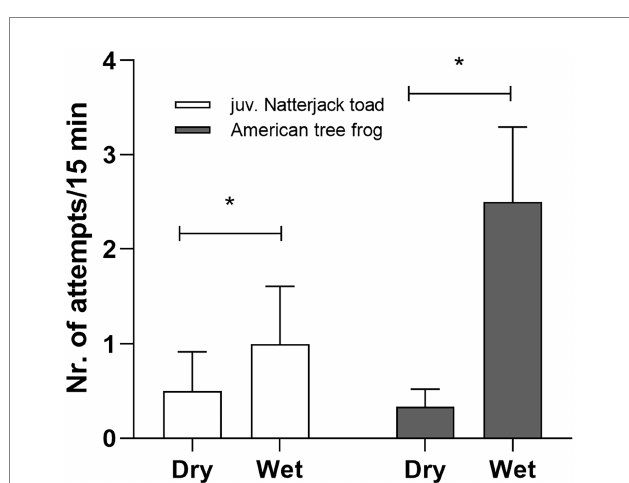
FIGURE 5 Number of crossing attempts per 15 min periods for two climbing species: juvenile Natterjack toads (N = 20) and adult American tree frogs (N = 8). Both species preferentially used the wetted part of the fence ( t = 2,1, p <